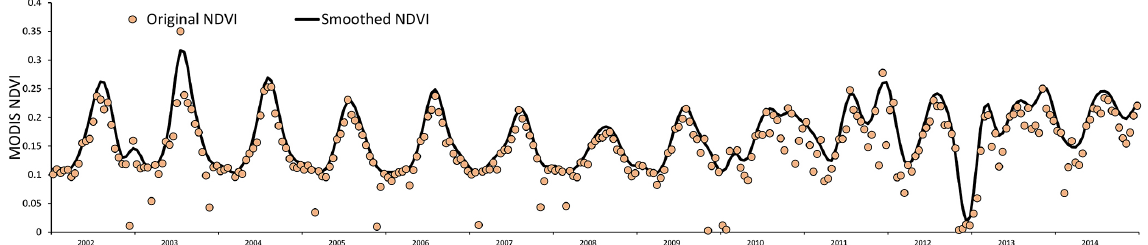
Figure 2. The original and smoothed MODIS NDVI time series from the Chifeng meteorology station from 2002 to 2014 (42 ◦ 16 (cid:48) N, 118 ◦ 56 (cid:48)